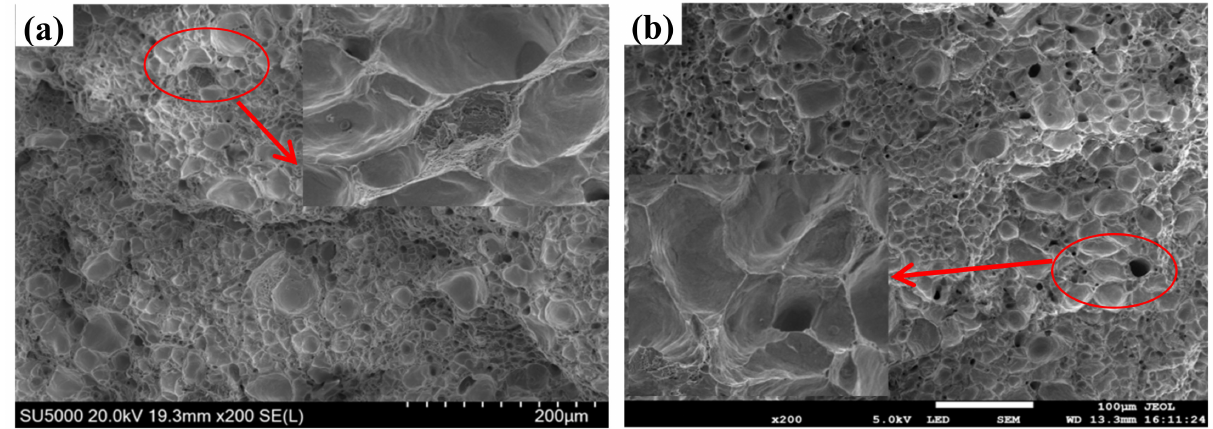
Figure 14. Tensile fractographs of ZCuPb20Sn5-yB alloy. ( a ) B 0.1; ( b ) B 0.2.